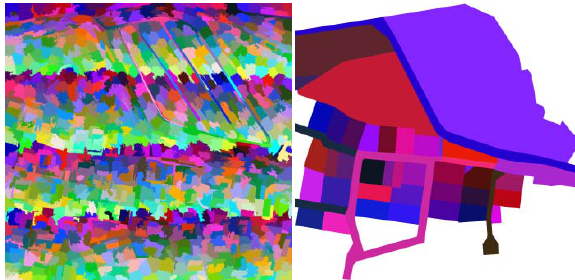
Figure 2: Region images representing superpixels (left) and land use objects (right). The colours bear no